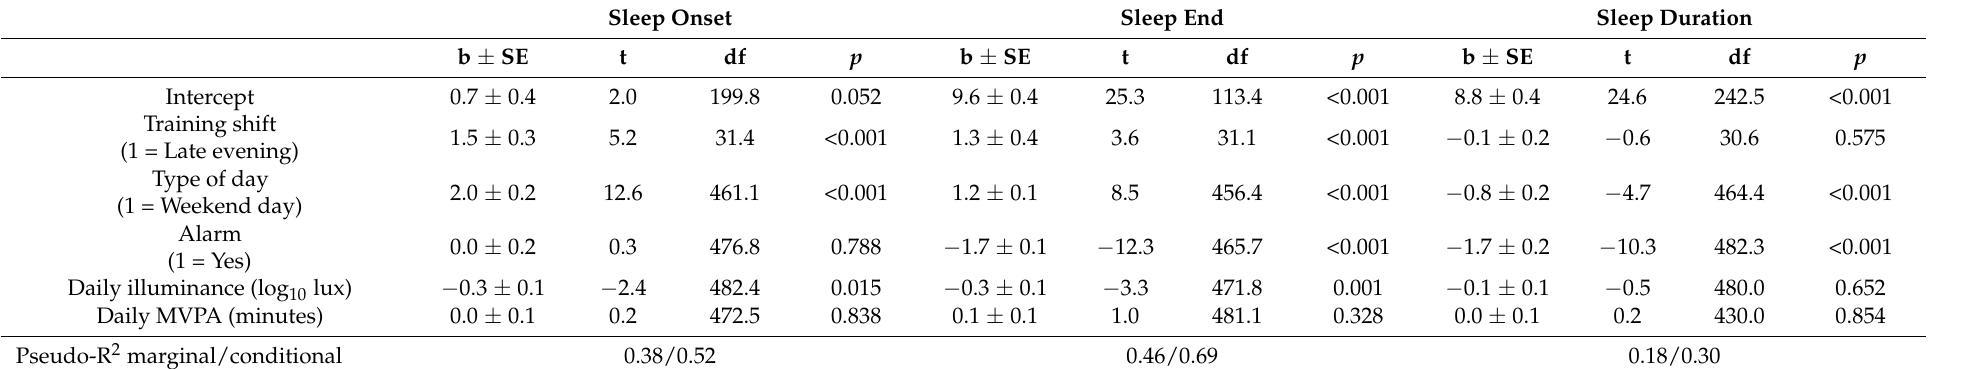
Table A1. Mixed-effects linear regressions for estimating sleep parameters (454